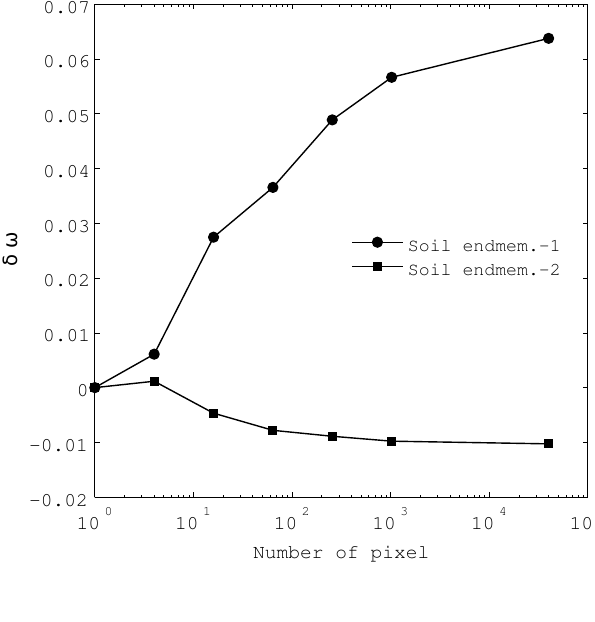
Figure 3. Scaling effects of area-averaged FVC, calculated based on the NDVI-isoline-based LMM as a function of the spatial resolution, using two pairs of endmember spectra. The averaged FVC derived using the vegetation endmember and the soil endmem.-1 spectra is indicated by the filled circles. The averaged FVC derived using the vegetation endmember and soil endmem.-2 spectra is indicated by the filled squares. Increasing and decreasing trends in the averaged FVC depend on the choice of endmember spectra assumed in the model. (The trend also depends on the endmember spectra present over the target